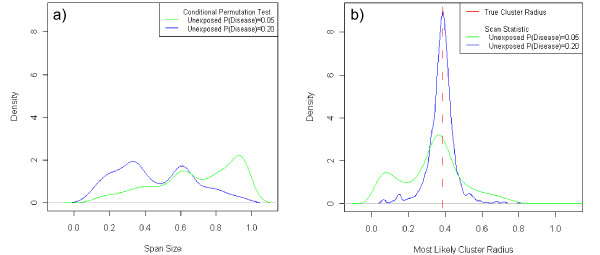
Distributions of Optimal Span Size and Most Likely Cluster Radius Observed for Case 1 with Odds Ratio of 3.0. a: Case 1 Conditional Permutation Test Optimal Span Size for Odds Ratio of 3.0. This figure depicts the optimal span size selected by applying GAMs across a range of possible spans and selecting the optimal span as that which corresponds to the minimal model AIC statistic. b: Case 1 Scan Statistic Most Likely Cluster Radius for Odds Ratio of 3.0. This figure depicts the distribution of the observed radius for most likely clusters selected by the scan statistic. It is paired with Figure 4a as we can compare the tendencies of the methods to over- or under-smooth through these figures. With Figure 4a we see that for lower disease prevalence the GAM methods tend to choose a large span size, possibly over-smoothing and missing the cluster. The scan statistic tends to under-smooth and finds a most likely cluster that is much smaller than the true cluster radius, as shown in Figure 4b.